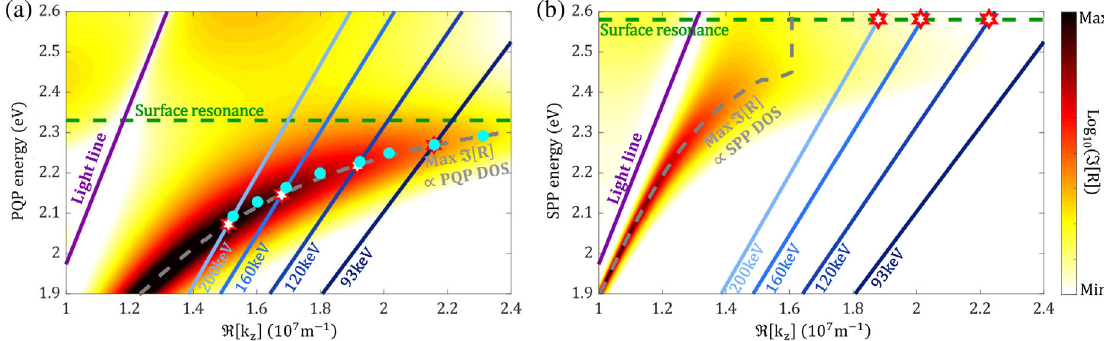
FIG. 6. Achieving Cherenkov phase matching for free electrons and optical excitations: comparison between the PQPs in our structure and the more conventional SPPs at the gold-vacuum interface. The colored backgrounds present the imaginary part of the reflection coefficient, which is proportional to the photonic density of states (DOS) of the surface modes, for (a) our metal-dielectric waveguide and (b) a gold-vacuum interface. The dashed gray curve follows the maximal value of the imaginary part of the reflection coefficient. The Cherenkov phase-matching condition is approximately given by the intersection (red stars) between the maximal DOS curve and a line with slope following the electron velocity (shades of blue). (a) The metal-dielectric waveguide structure: showing the velocity dependence of the energy at which the phase-matching condition is satisfied, corresponding to the shifts in the measured EELS peaks. The full calculation shows a slight blueshift compared with the predictions made by the DOS for most energies (i.e., the cyan dots are above the gray dashed line). The blueshift arises from including emission into all angles, which is considered in the full calculation and not captured by the density of state consideration. For large wave vectors, the PQPs are more lossy, leading to a slight redshift of the peak, which explains why for higher electron energies the full theory coincides more accurately with the PQP dispersion. (b) The gold- vacuum interface: showing that there are no intersection points with the curving dispersion of the gold-vacuum SPPs before it flattens to the constant surface plasmon resonance. Consequently, there is no velocity dependence and no shift in the EELS